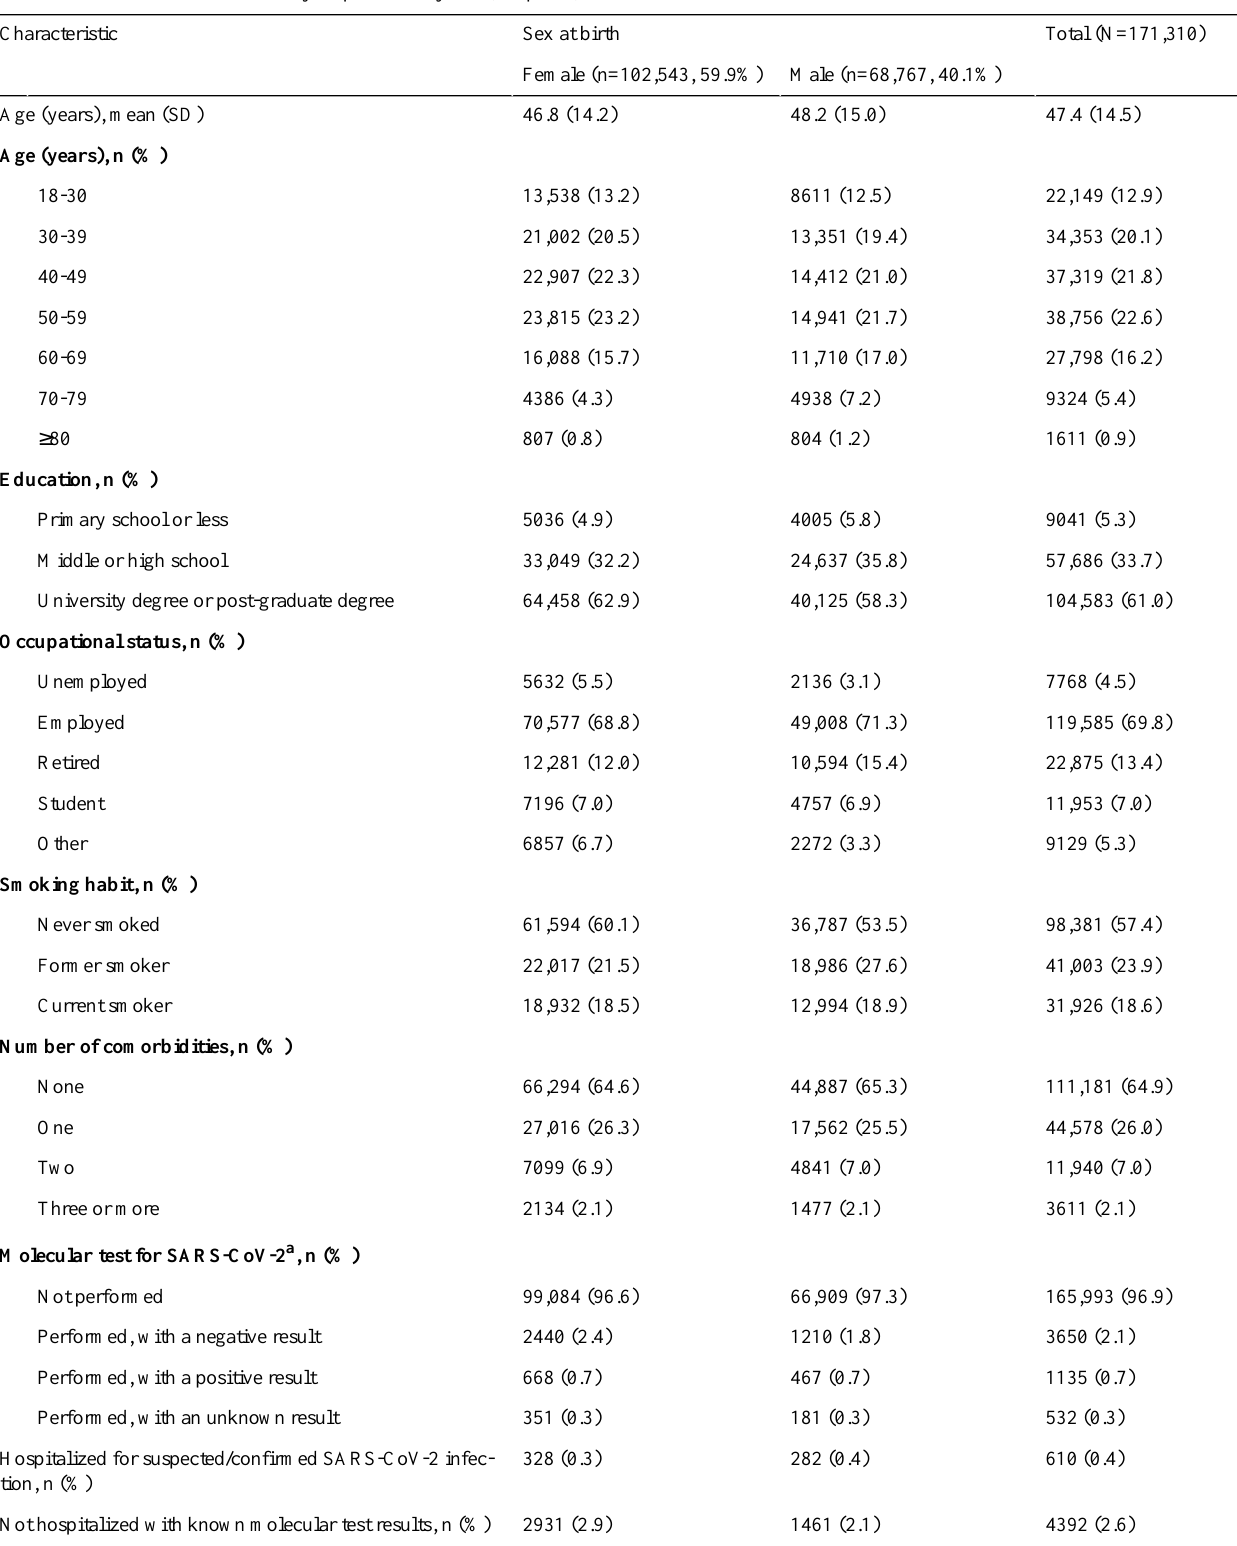
Table 1. Characteristics of the survey respondents by sex (sample A).